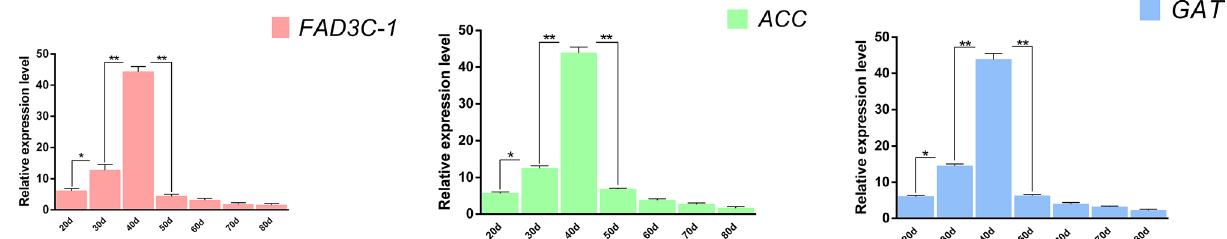
Figure 2. Analysis of relative expression levels of FAD3C-1 , ACC and GAT genes in soybean during seven developmental stages from 20 to 80 d after soybean flowering. *Indicates a statistical difference at p < 0.05, **indicates a statistical difference at p < 0.01.